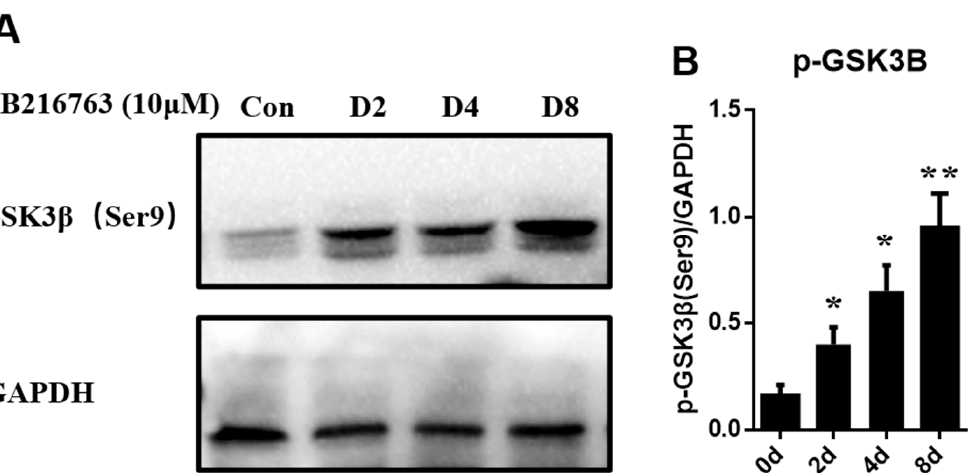
Figure 3. Effects of time-course SB216763 treatment on the phosphorylation levels of GSK3 β in sheep SMSCs. Cells were serum starved for 6 h, then SB216763 (10 μ M) was added for 0, 2, 4, and 8 days. ( A ) Phosphorylation of GSK3 β (Ser9) was induced by SB216763 in sheep skeletal muscle satellite cells. ( B ) Quantified results of western blots . p < 0.05 (*) and p < 0.01 (**) relative to 0 d of differentiation.